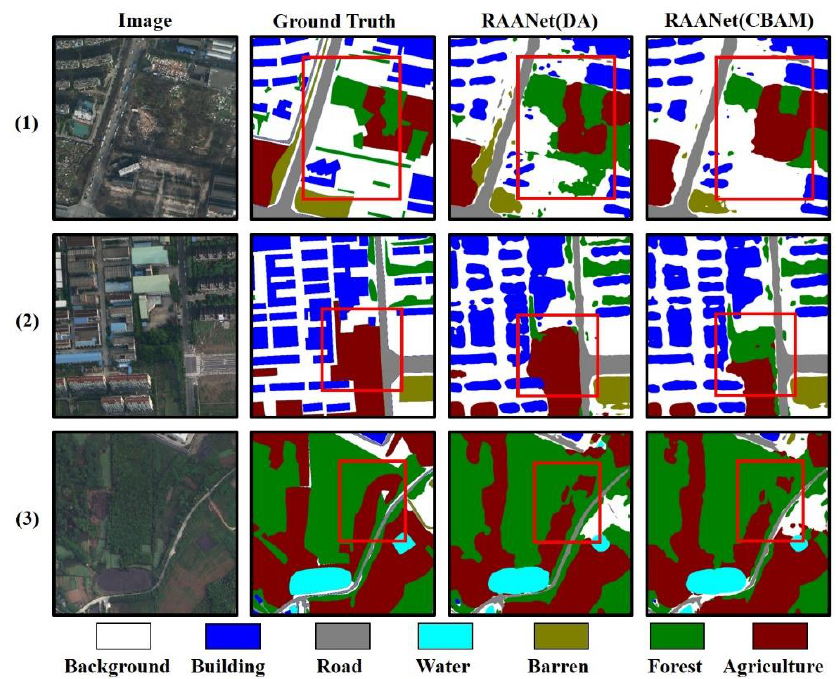
Figure 9. Prediction results of RAANet (DA) and RAANet (CBAM) for agriculture, barren, and forest. ( 1 – 3 ) represents three random parts of the experimental sample.